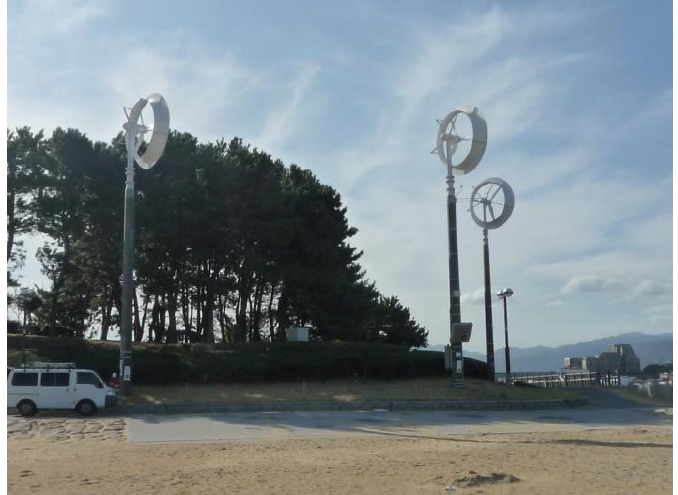
Figure 20. 5 kW Wind-lens turbines in a seashore park in Fukuoka city,